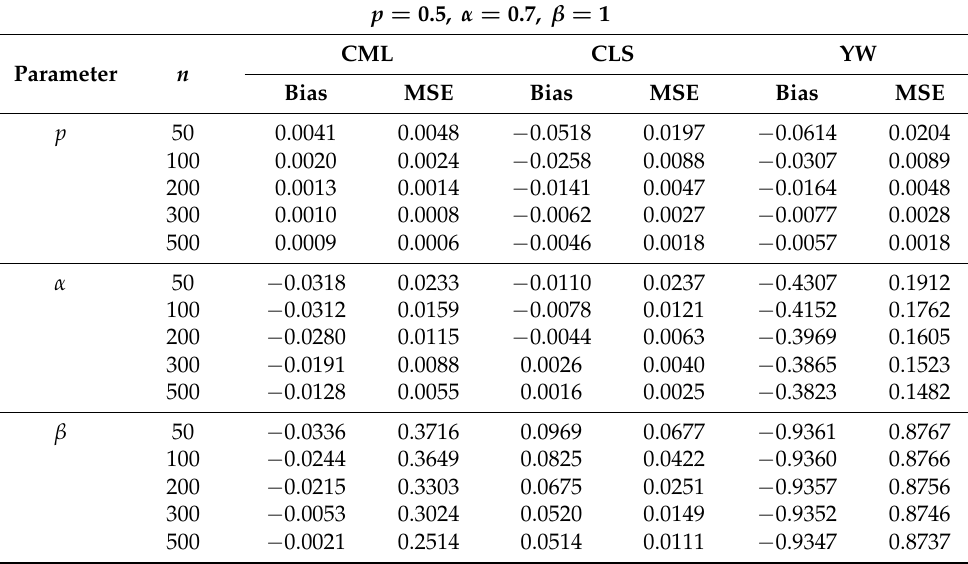
Table 6. Simulation for the INAR(1)PEE model for p = 0.5, α = 0.7 and β = 1. p = 0.5, α = 0.7, β = 1